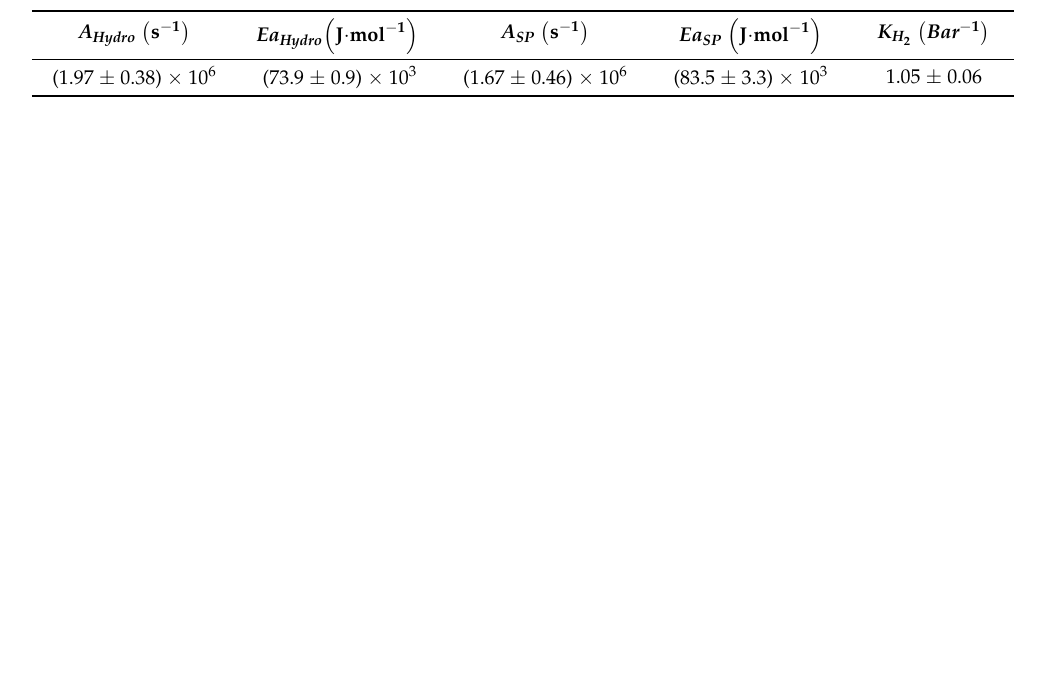
Table 11. Estimated parameters for Model 3 with 95% confidence